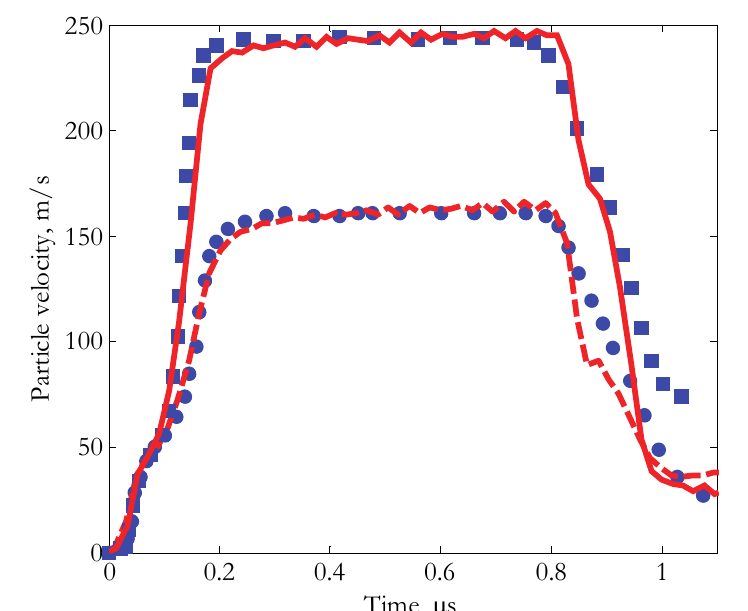
Figure 4: Particle velocity profiles for vanadium sample. The solid line is stress amplitude value about 9.7 GPa (numerical calculation), the dashed line − 6.4 GPa (numerical calculation), ○ − 9.7 GPa (experiment), □ − 6.4 GPa (experiment) [33]